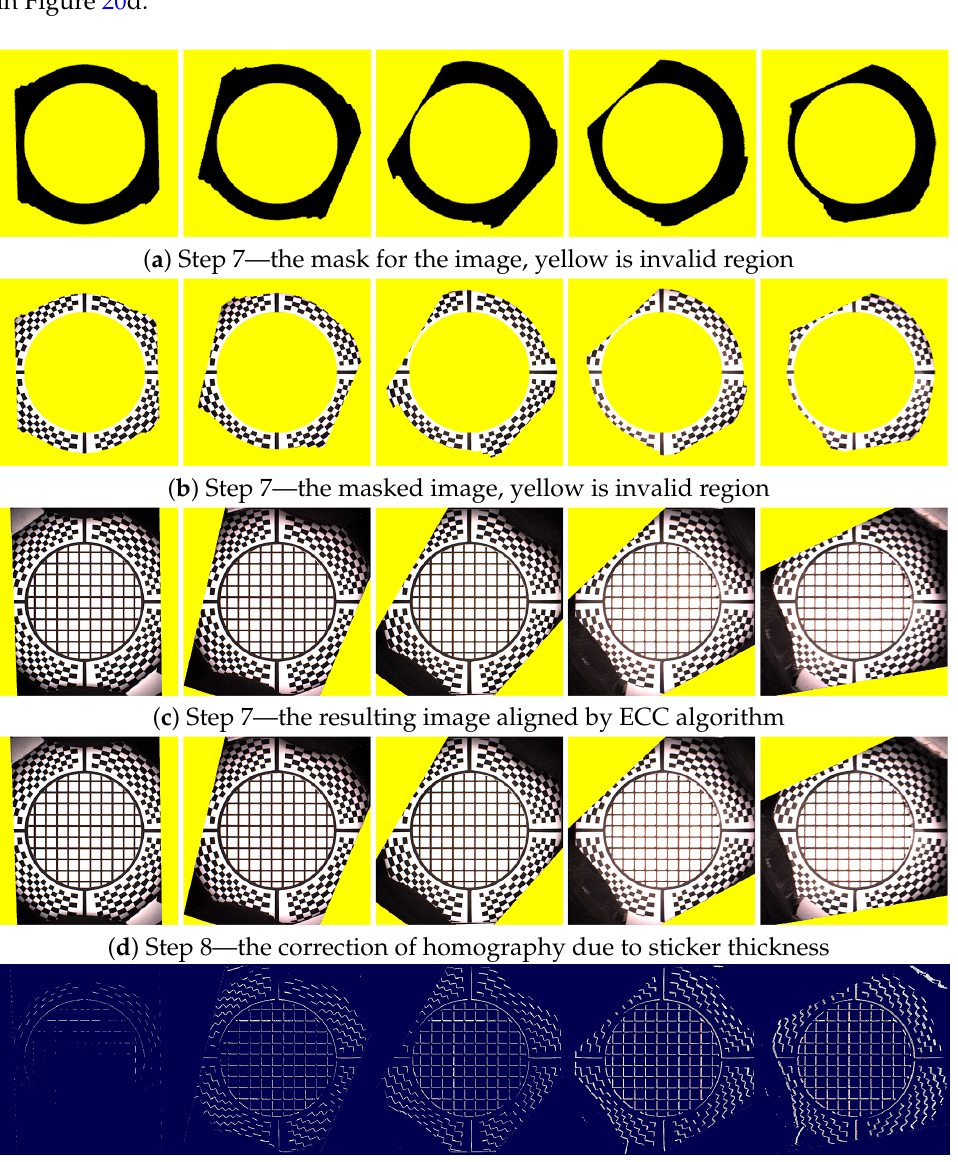
Figure 21. Completing image registration: ( a – c ) step 7—image alignment by ECC algorithm; ( d ) step 8—the image after the homography change due to the sticker thickness; ( e ) The difference image between images of step 7 and